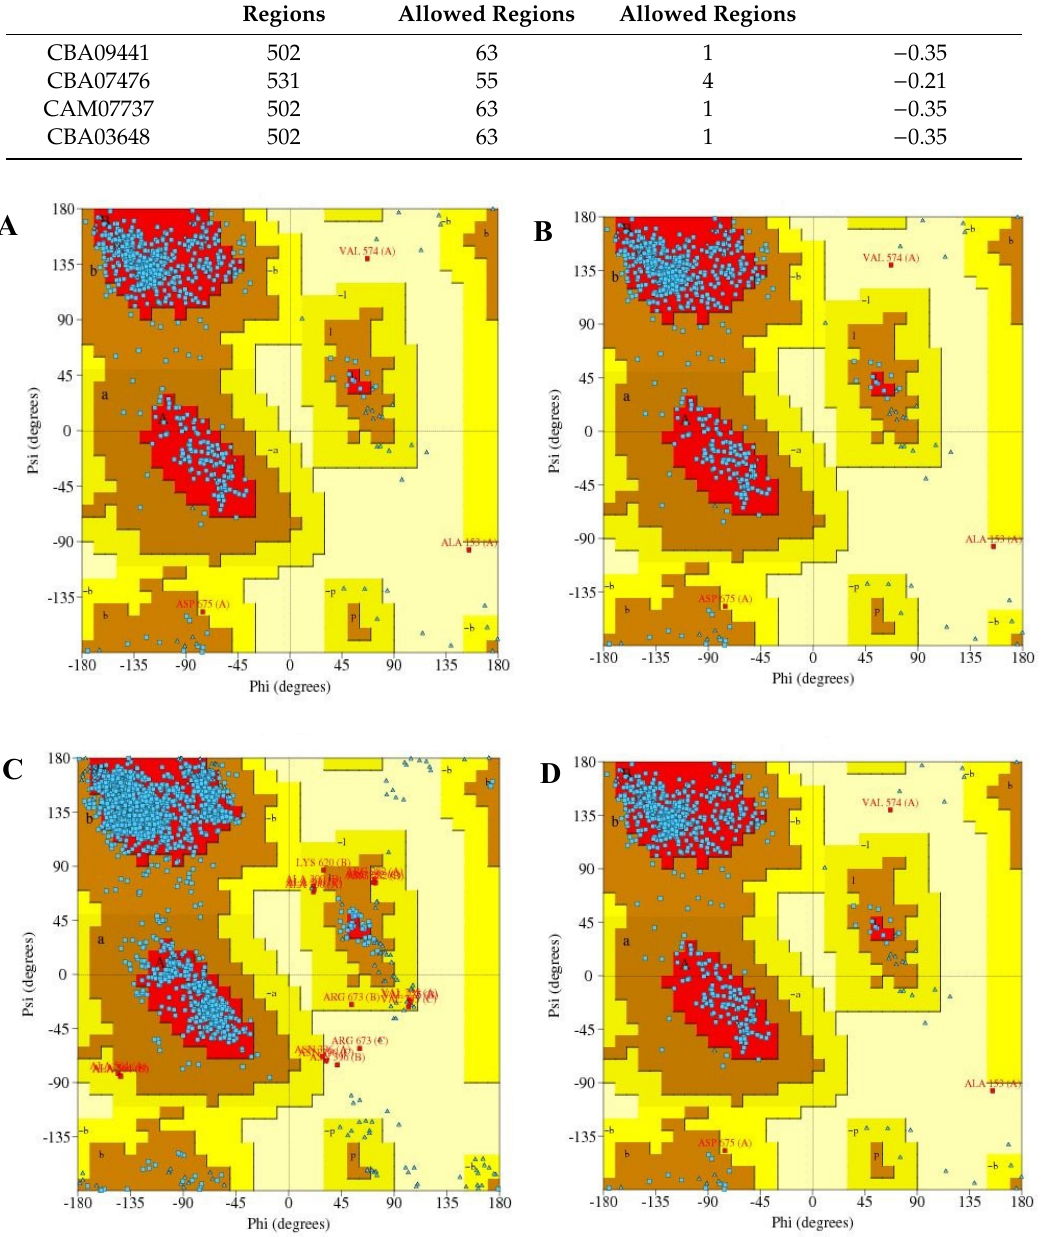
Figure 2. Ramachandran plot of predicted protein models. ( A ) CAM07737 (714 amino acids). ( B ) CBA03648 (723 amino acids). ( C ) CBA07476 (721 amino acids). ( D ) CBA09441 (713 amino acids). The residues in red zone indicate their position in most favored regions.